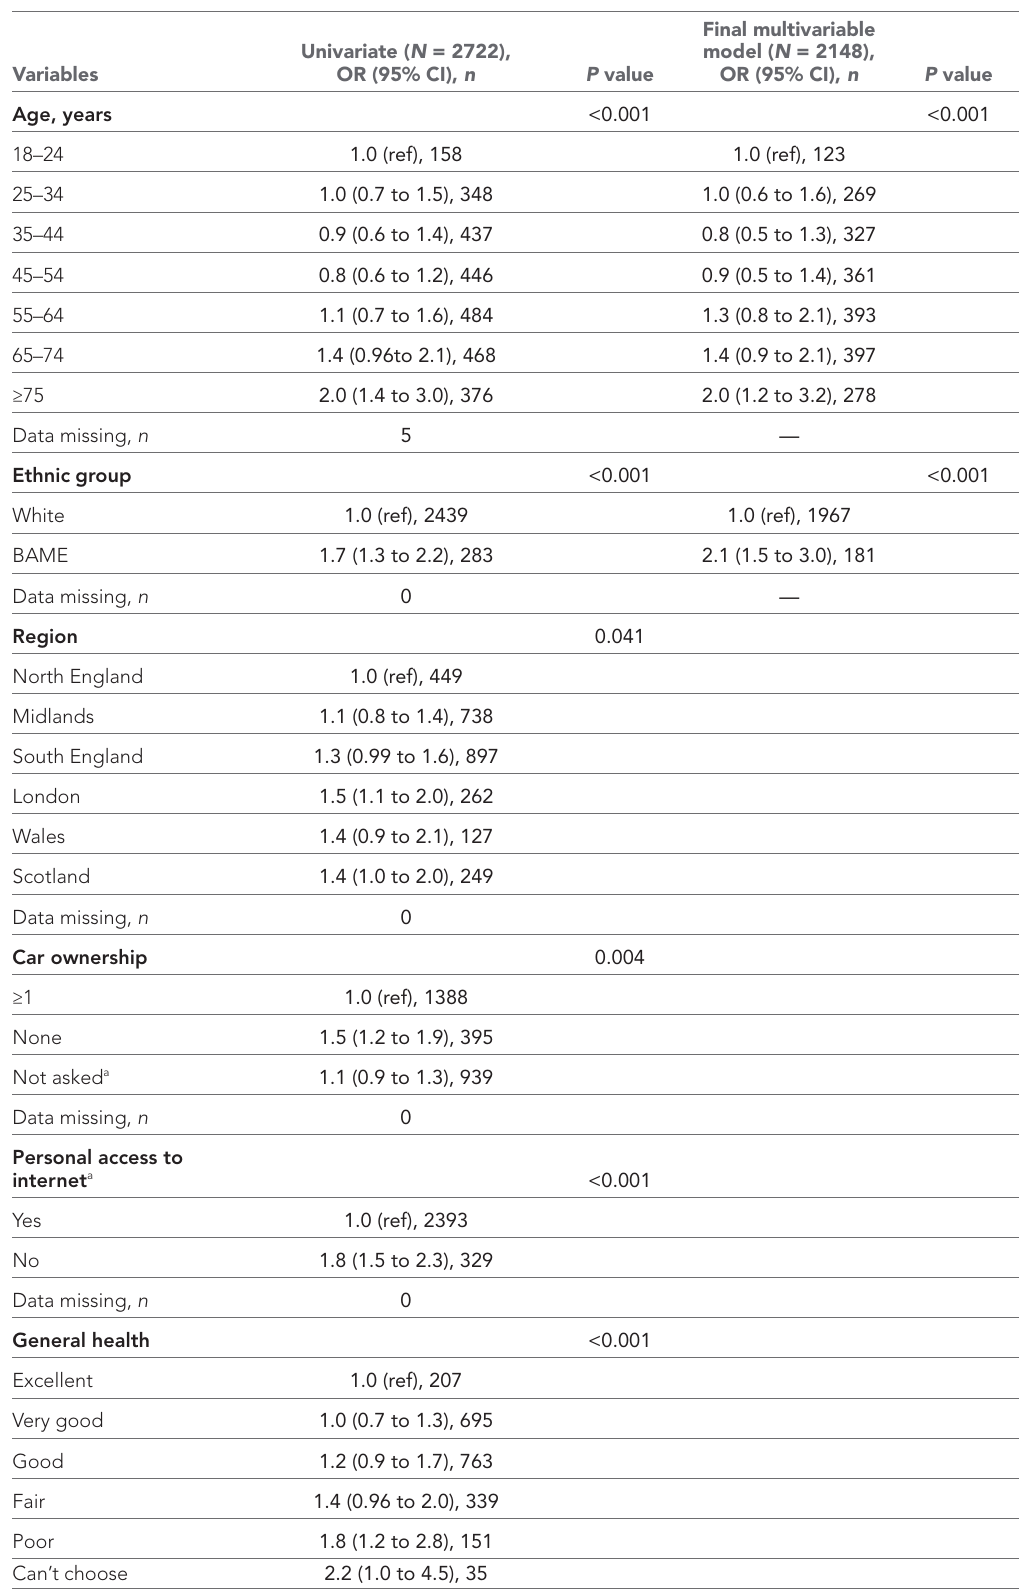
Table 4 Sociodemographic characteristics of tendency to contact GP rather than self- care for minor